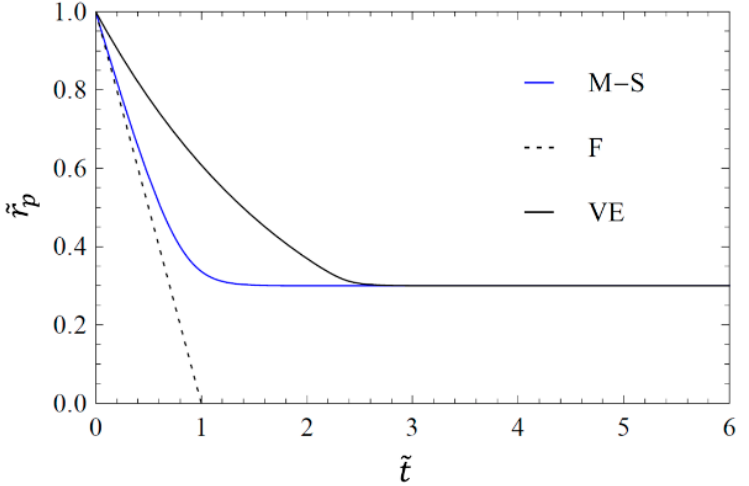
Figure 2. Solution curves for the Frenkel model (F), the (modified) Mackenzie and Shuttleworth model (M–S) and the viscoelastic model described in this paper (VE) for parameter values of (cid:101) r p , eq = 0.3 and (cid:101) λ = 1.